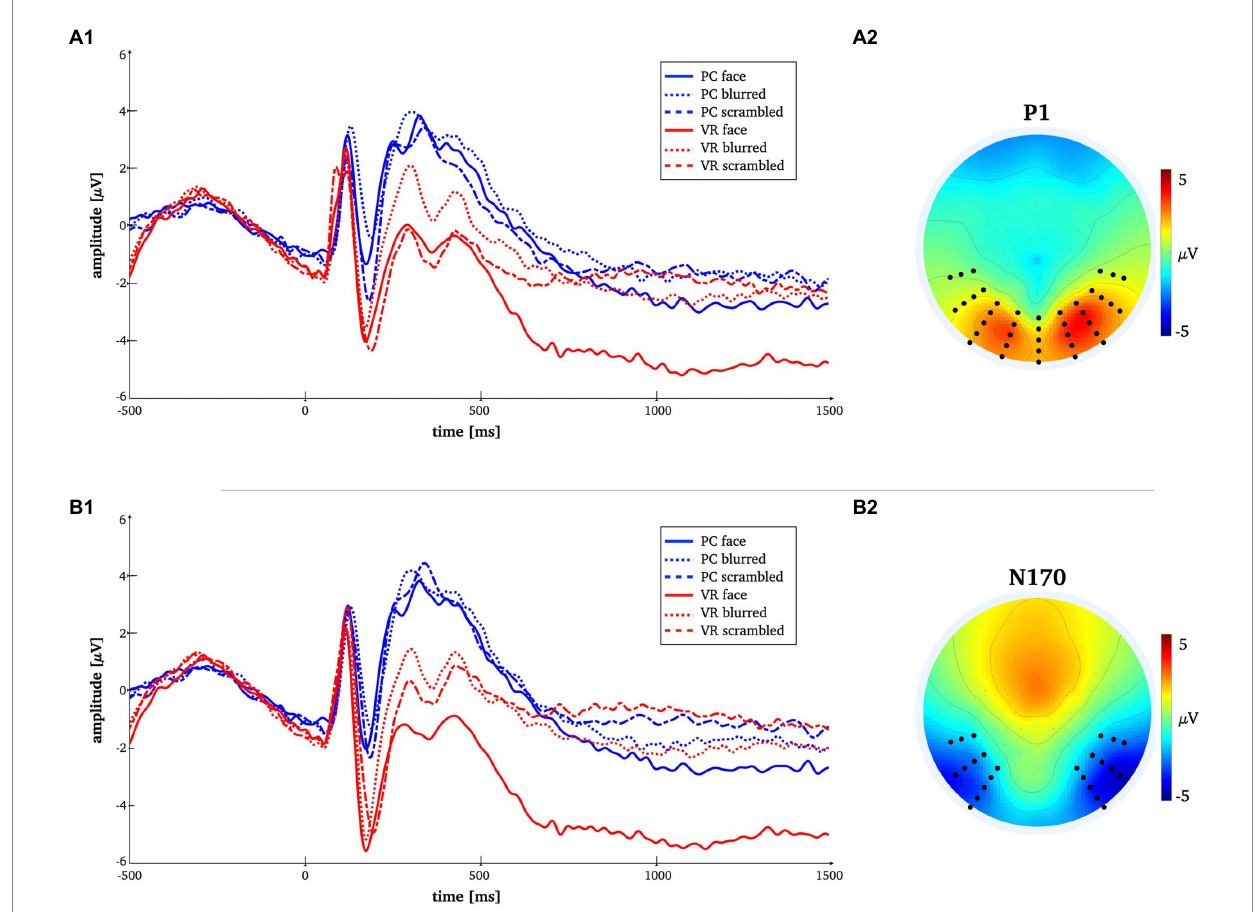
FIGURE 3 Time-by-amplitude plot of the mean P1 and N170 amplitudes for all conditions [panels A1,B1 ]. Mean topographies across conditions used for ERP averaging [panel A2,B2 ]. The electrodes selected for analyses are indicated. For the P1 electrodes Oz, O1, O2, P7, PO7, P8, PO8, TP7, TP8 and those in close vicinity were used. For the N170 electrodes P7, P8, PO7, PO8, P10, P9, PO10, PO9, TP7, TP8 and those in close vicinity were used.